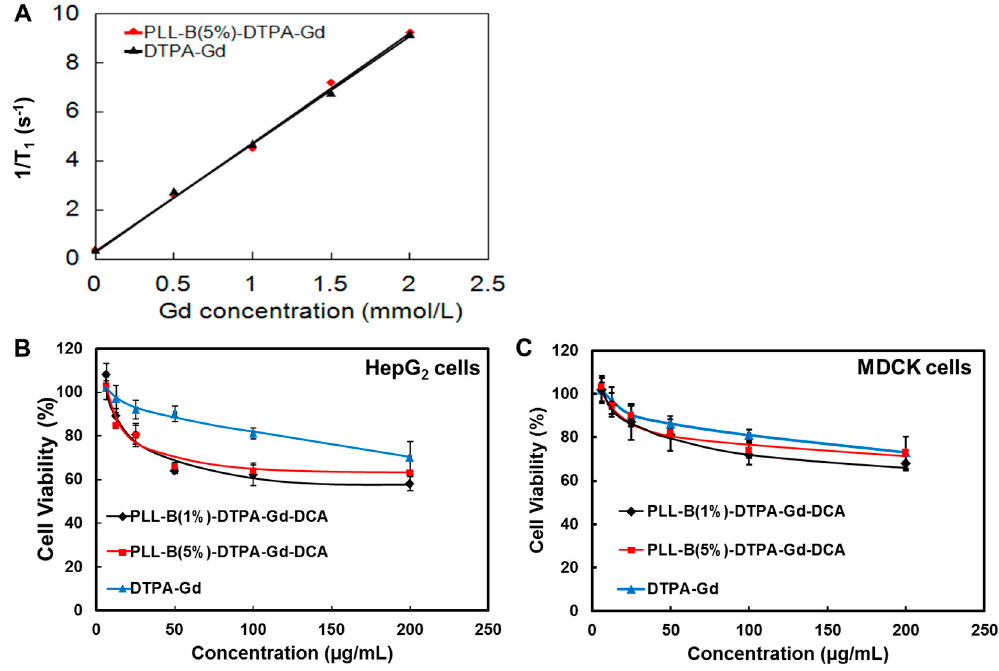
Figure 3. ( A ) Relaxation rates of PLL-B(5%)-DTPA-Gd and DTPA-Gd solutions at different concentrations (0.52 T and 32 °C). Cytotoxicity of PLL-B(1%)-DTPA-Gd-Rodamine-DCA and PLL-B(5%)-DTPA-Gd-Rodamine-DCA to HepG 2 cells ( B ) and Madin–Darby Canine Kidney (MDCK) cells ( C ), estimated by MTT assay. Cells were cultured in DMEM medium for 24 h. All solid lines are fitted to the data.